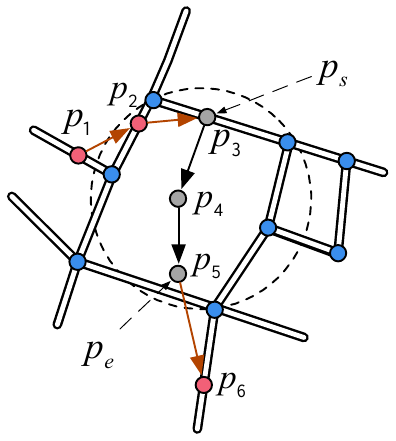
Figure 6. A PRS neighborhood in a road network.